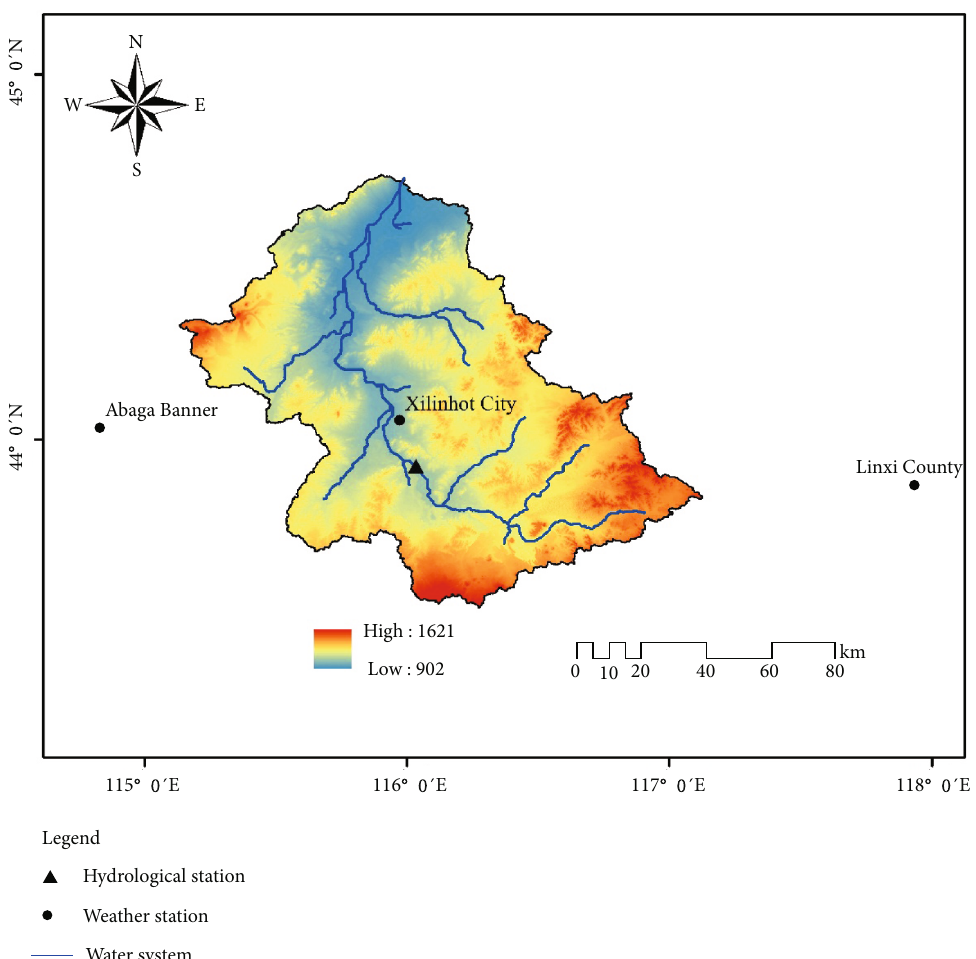
Figure 1: The location of Xilinhe River and related weather stations and hydrological